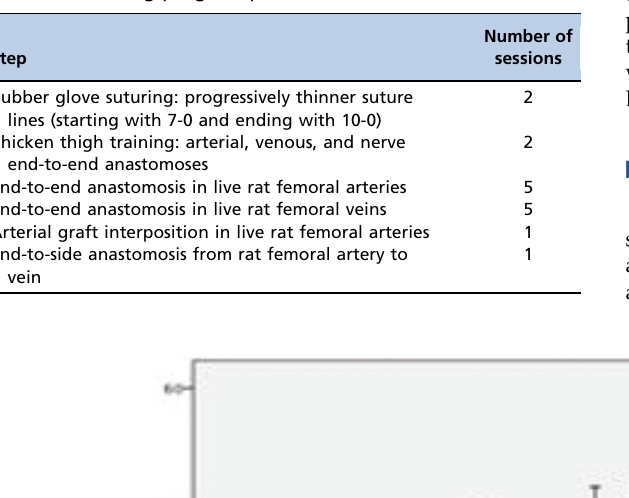
Table 1 - Training program particulars.